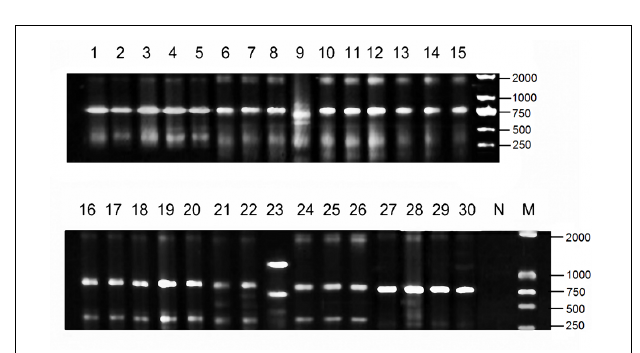
FIGURE 2 | Electrophoretogram of PCR product in Enterobacterial repetitive intergenic consensus sequence (ERIC) profiles of 30 KPC-producing Klebsiella pneumoniae clinical isolates investigated in this